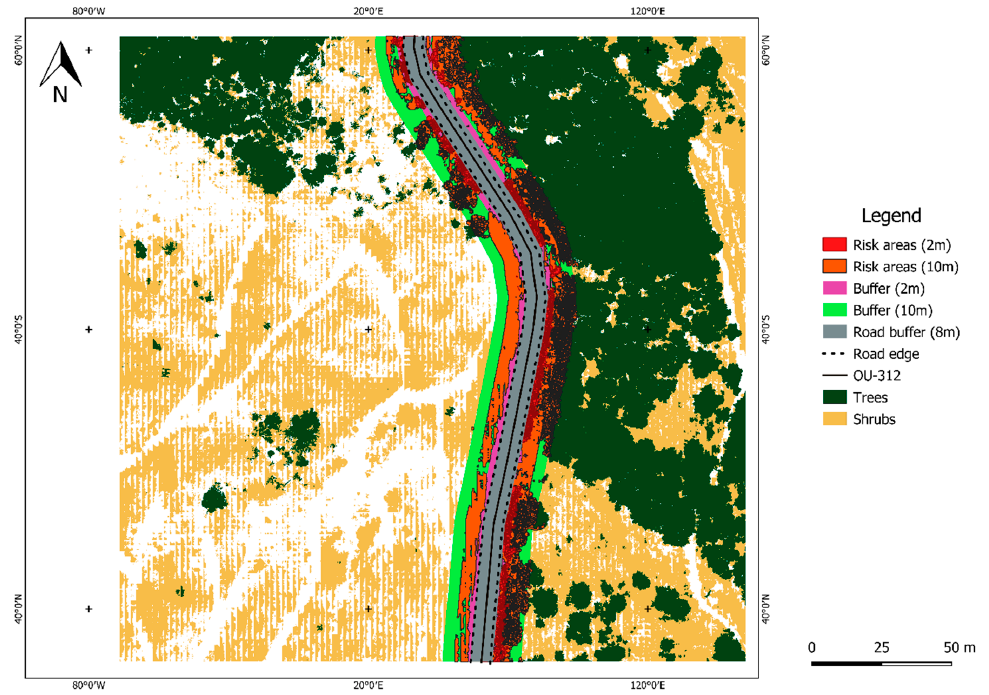
Figure 12. Risk areas of vegetation close to roads.